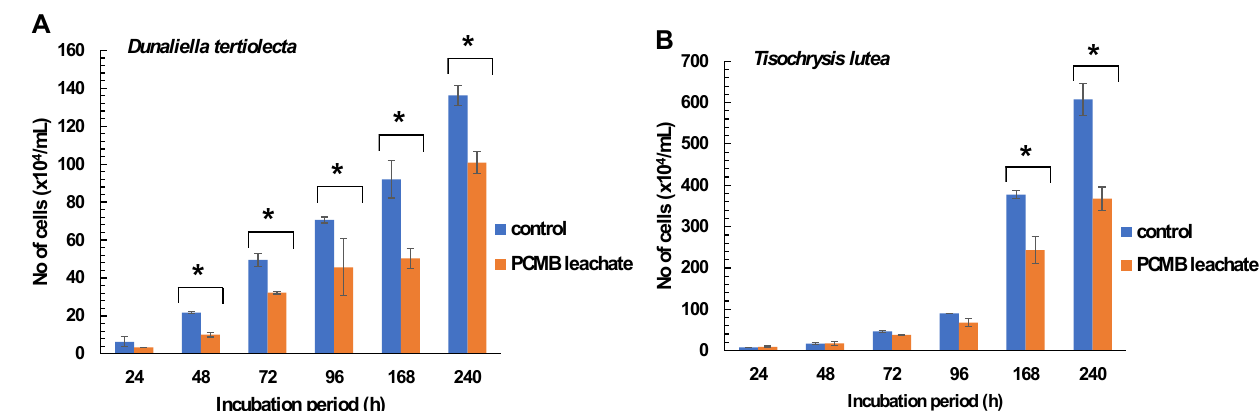
Figure 2. Effects of PCMB-ASW leachate in algal species ( A ) Dunaliella tertiolecta and ( B ) Tisochrysis lutea . The results (in terms of number of cells × 10 4 mL − 1 ) are mean ± SDs from 4 independent experiments. Asterisks (*) indicate significant difference between control and e-waste treated algae (Mann–Whitney u-test, p < 0.05).